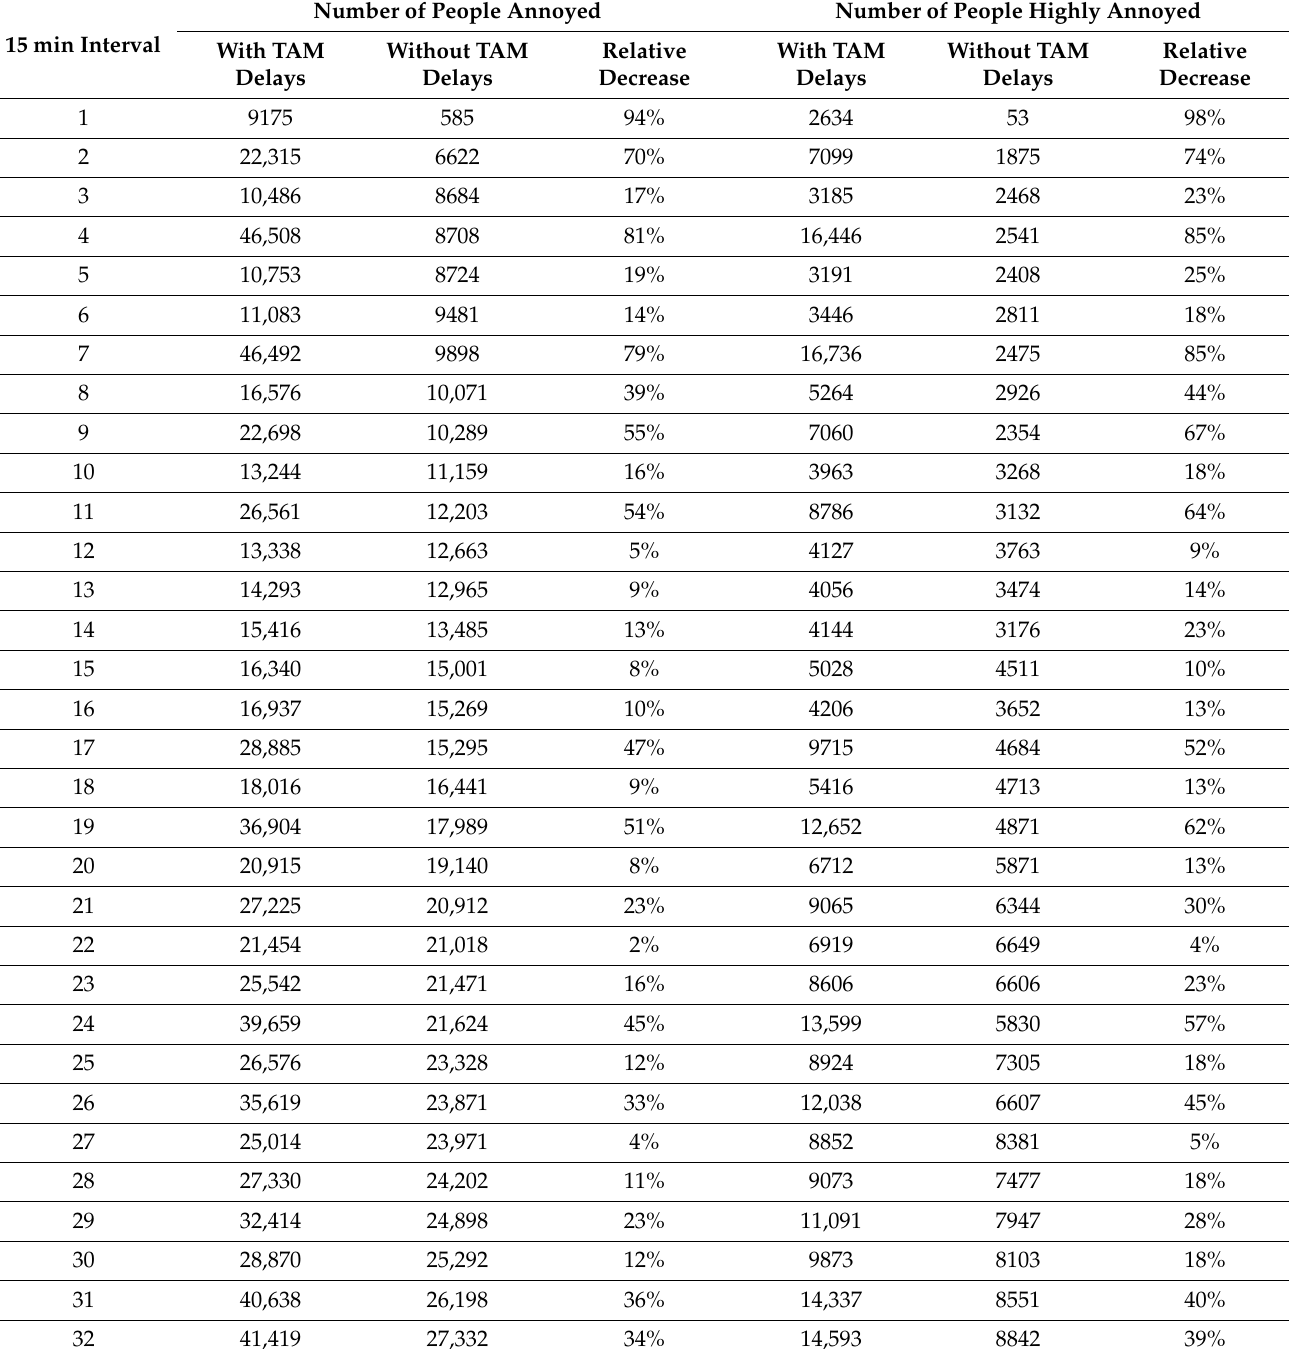
Table A1. Number of people annoyed and highly annoyed per interval (Sarajevo